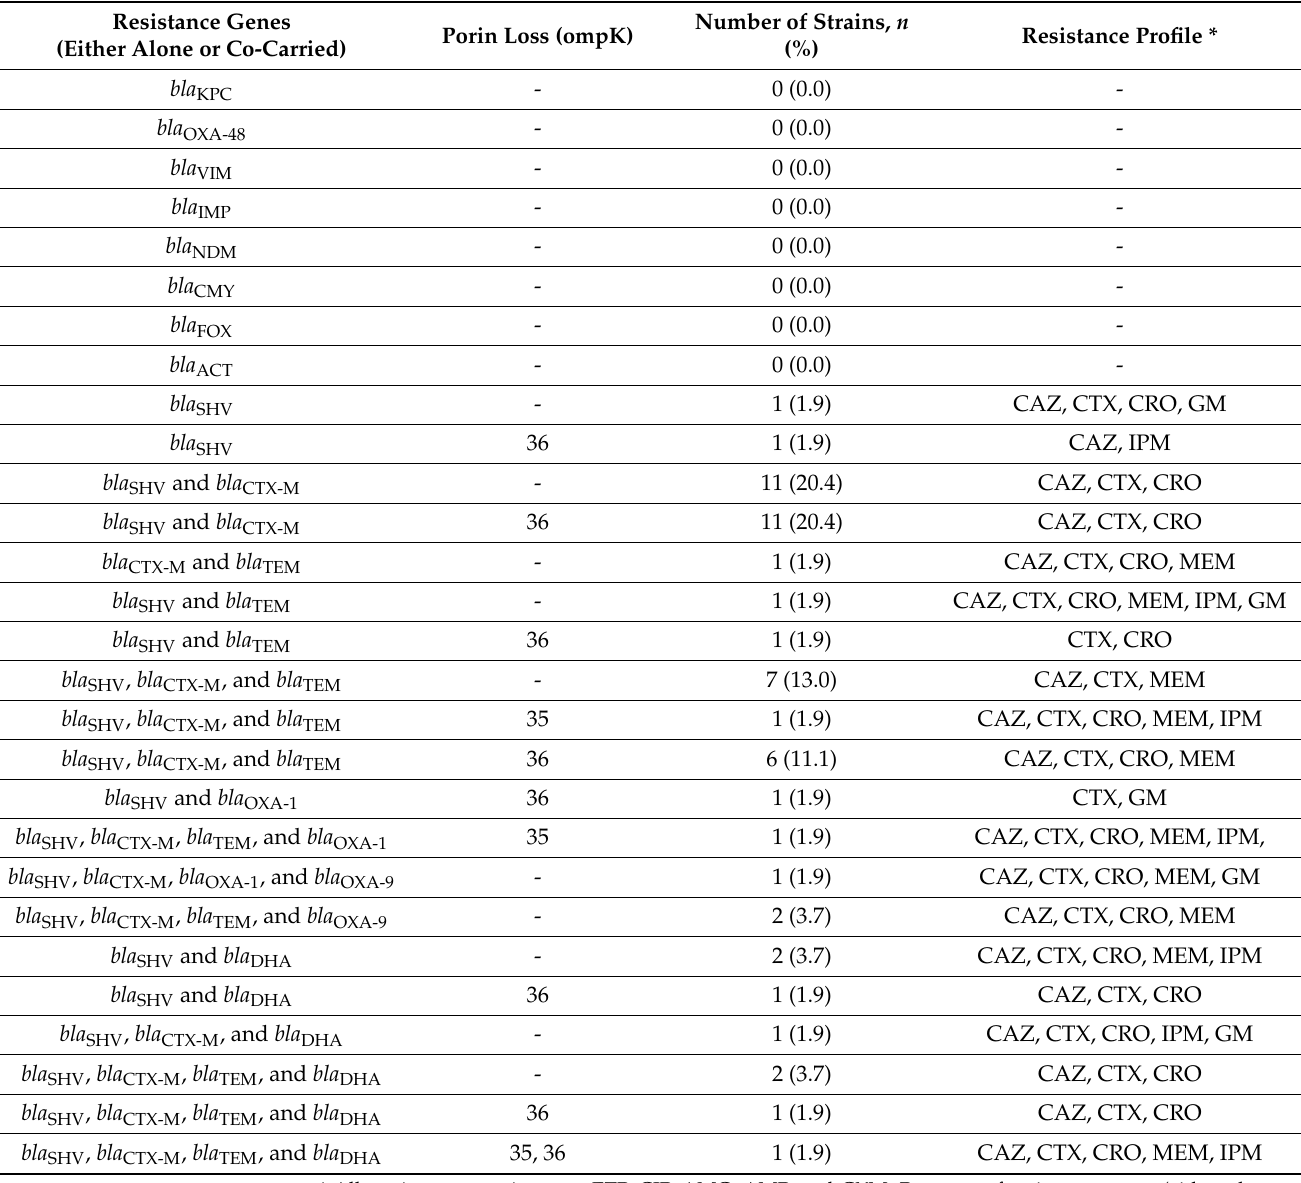
Table 4. Detection of resistance genes and porin-associated genes of all 54